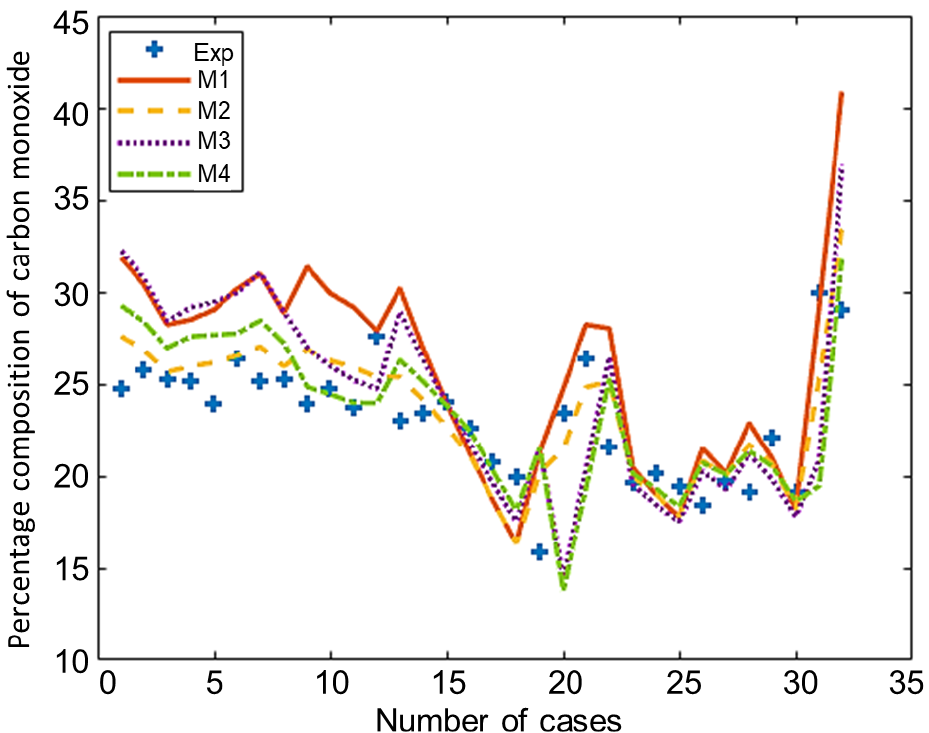
Figure 4. Comparison of carbon monoxide composition given by experiments and models.